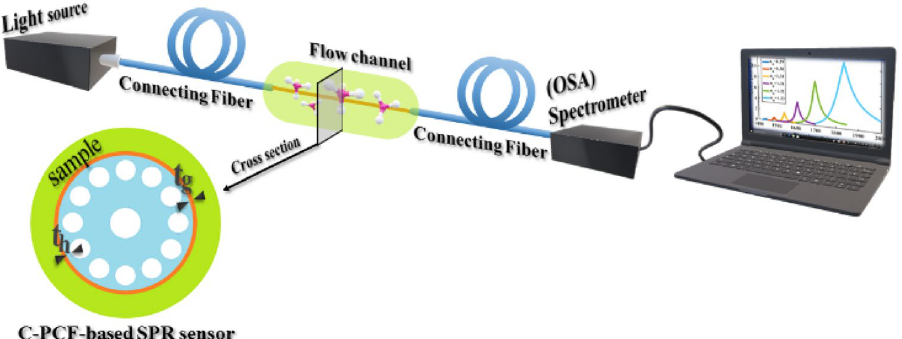
Figure 3. The schematic illustration of the proposed sensor in an experimental